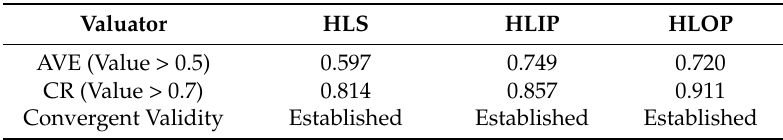
Table 7. Convergent validity